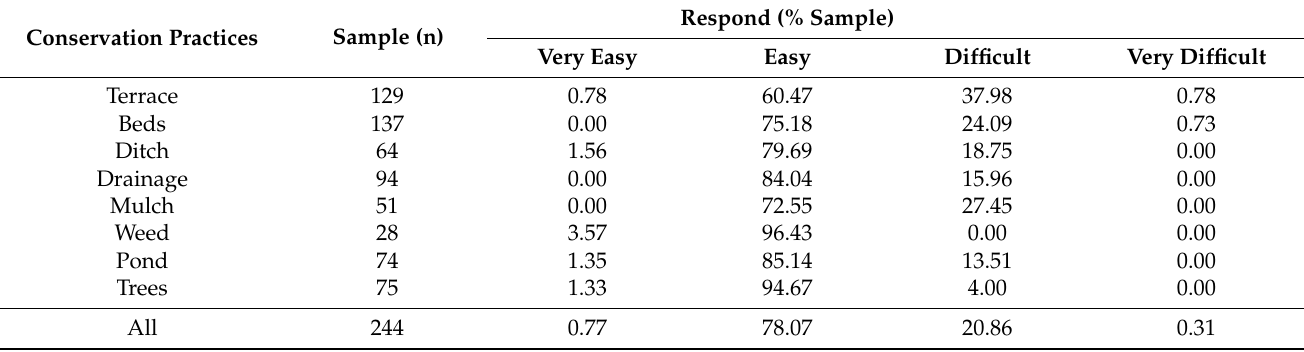
Table A2. Farmers’ perceptions related to the difficulties of each conservation